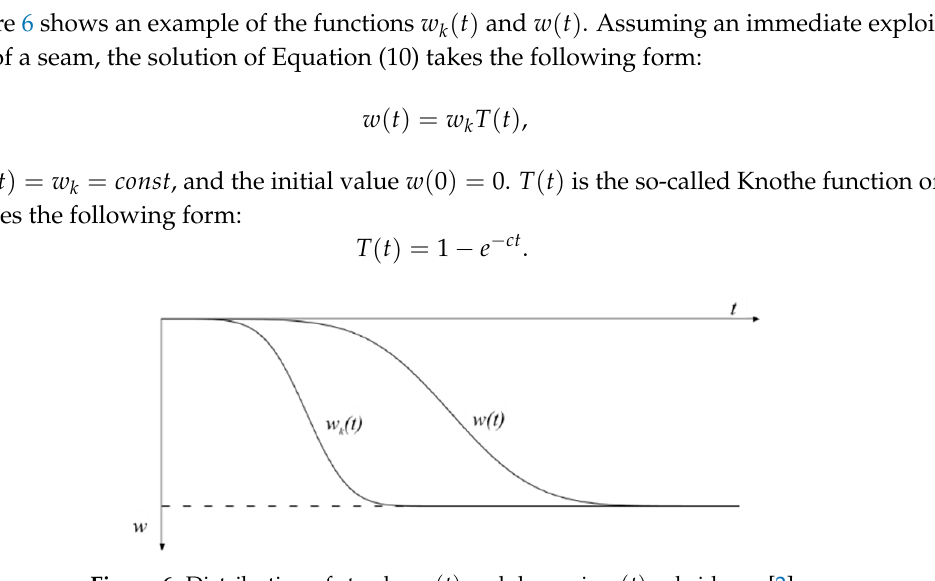
Figure 6. Distribution of steady 𝑤